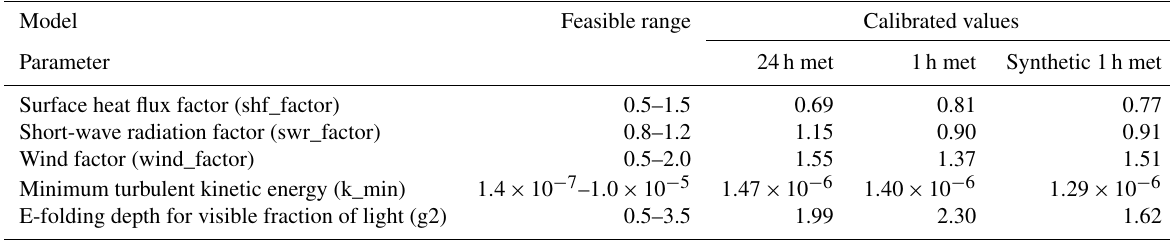
Table 2. GOTM lake model parameters and calibrated values. Model Feasible range